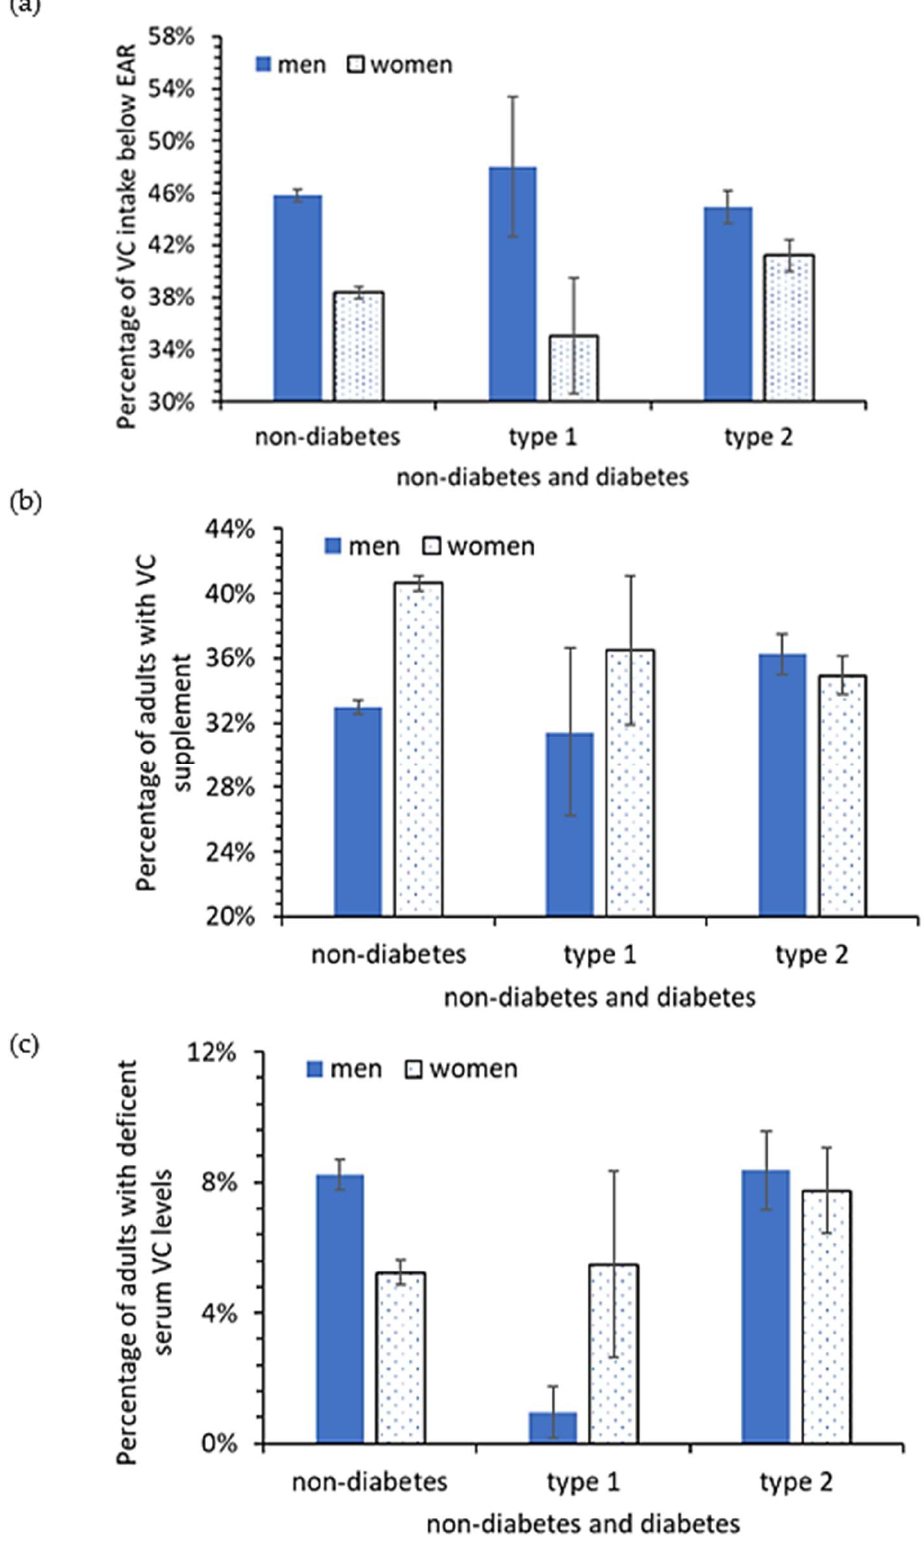
Figure 1. Percentages of US adults with ( a ), total VC intake below the VC EAR, ( b ), VC supplement, and ( c ), deficient serum VC. Vertical bars are standard errors.